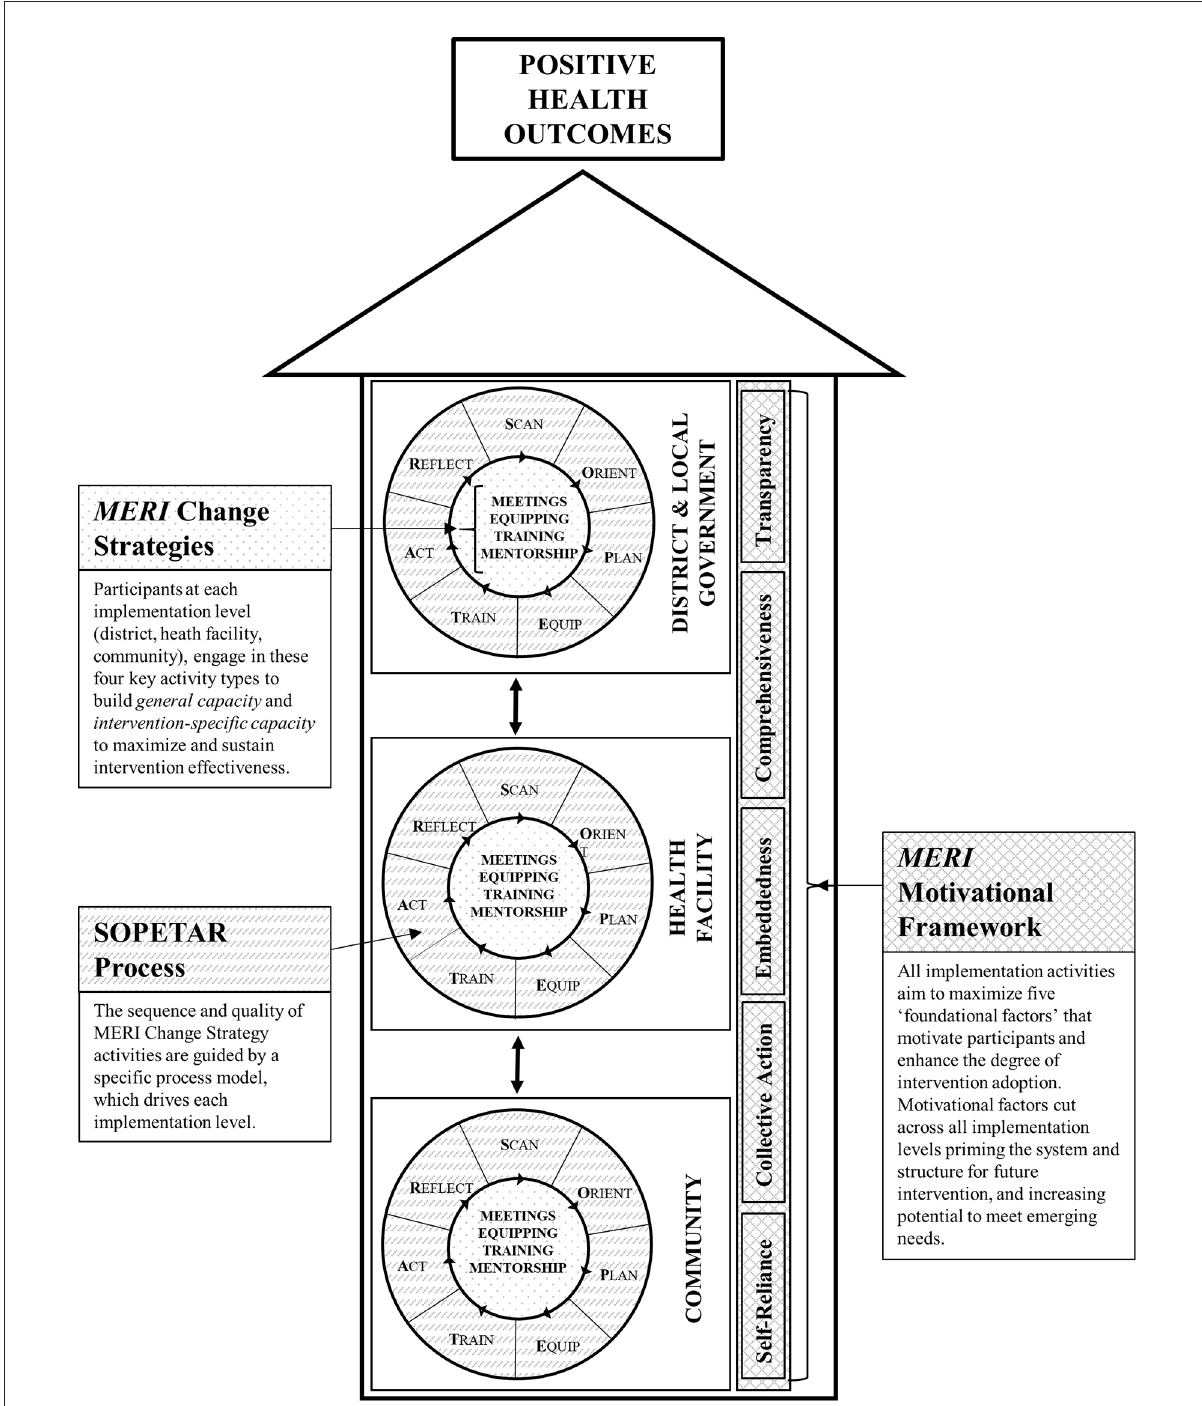
FIGURE1 How MERI Approach components work